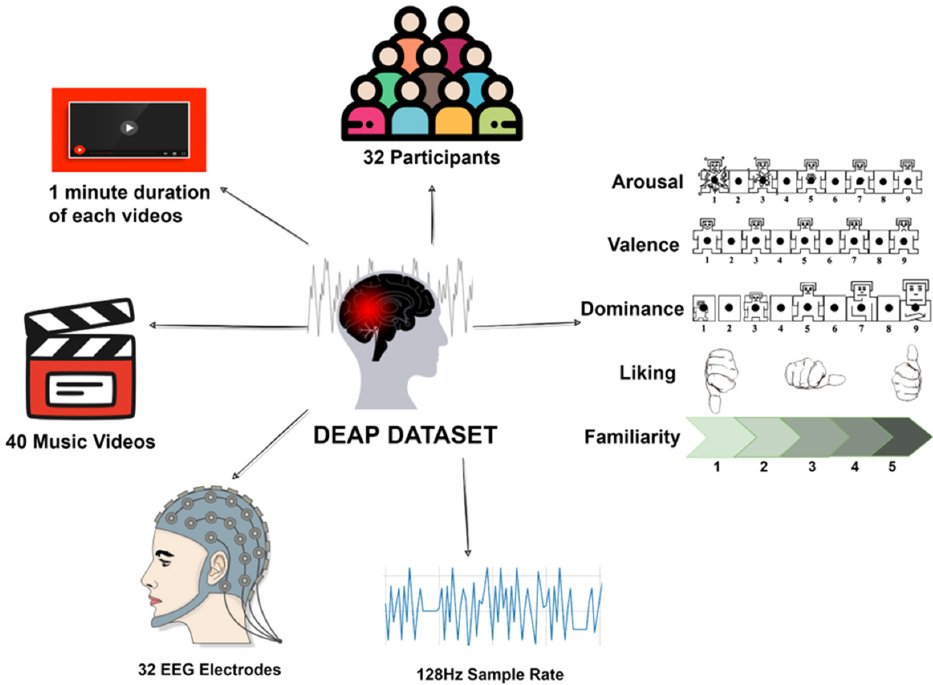
Figure 2. Overview of the DEAP dataset.